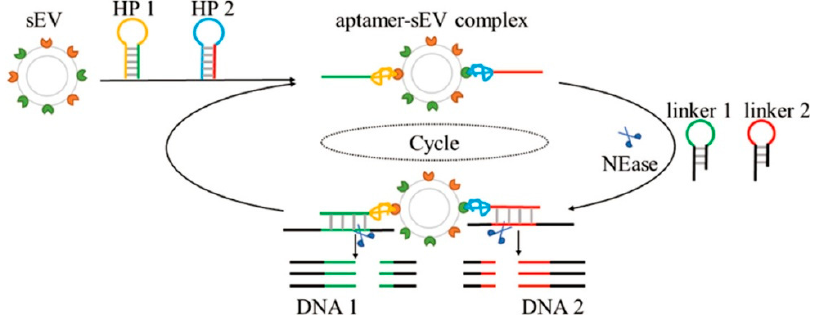
Figure 9. Dual-aptamer-assisted enzyme signal amplification. DNA hairpin structures 1 and 2 (HP1, HP2) can bind protein biomarkers on the surface of a small extracellular vesicles (sEV) leading to the release of the hybridization region (red and green parts of strands) that are complementary to regions in linkers 1 and 2 (color-coded the same). The restriction endonuclease (NEase) then recognizes and cleaves the new duplex. The resulting DNA1 and DNA2 can then have further downstream effects. Reprinted with permission from Yu, Y., Guo, Q., Jiang, W., Zhang, H., and Cai. C. 2021. Dual-aptamer-assisted AND logic gate for cyclic enzymatic signal amplification electrochemical detection of tumor-derived small extracellular vesicles. Anal. Chem., 93, 11298–11304.